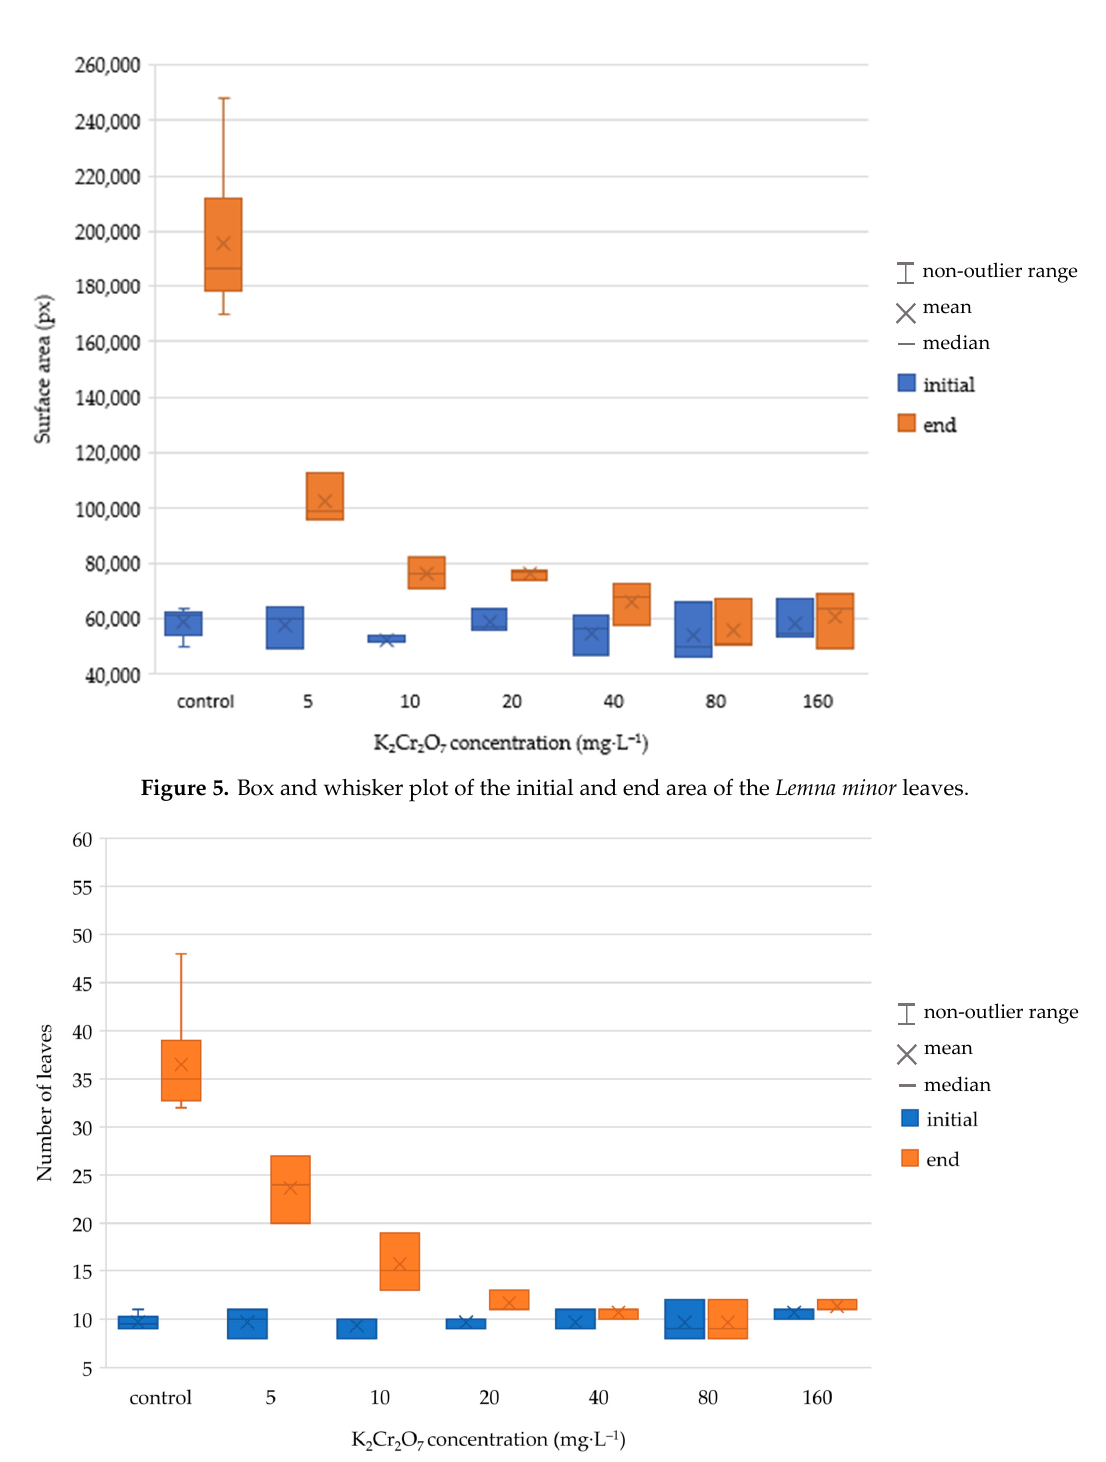
Figure 6. Box and whisker plot of the initial and end number of the Lemna minor leaves.